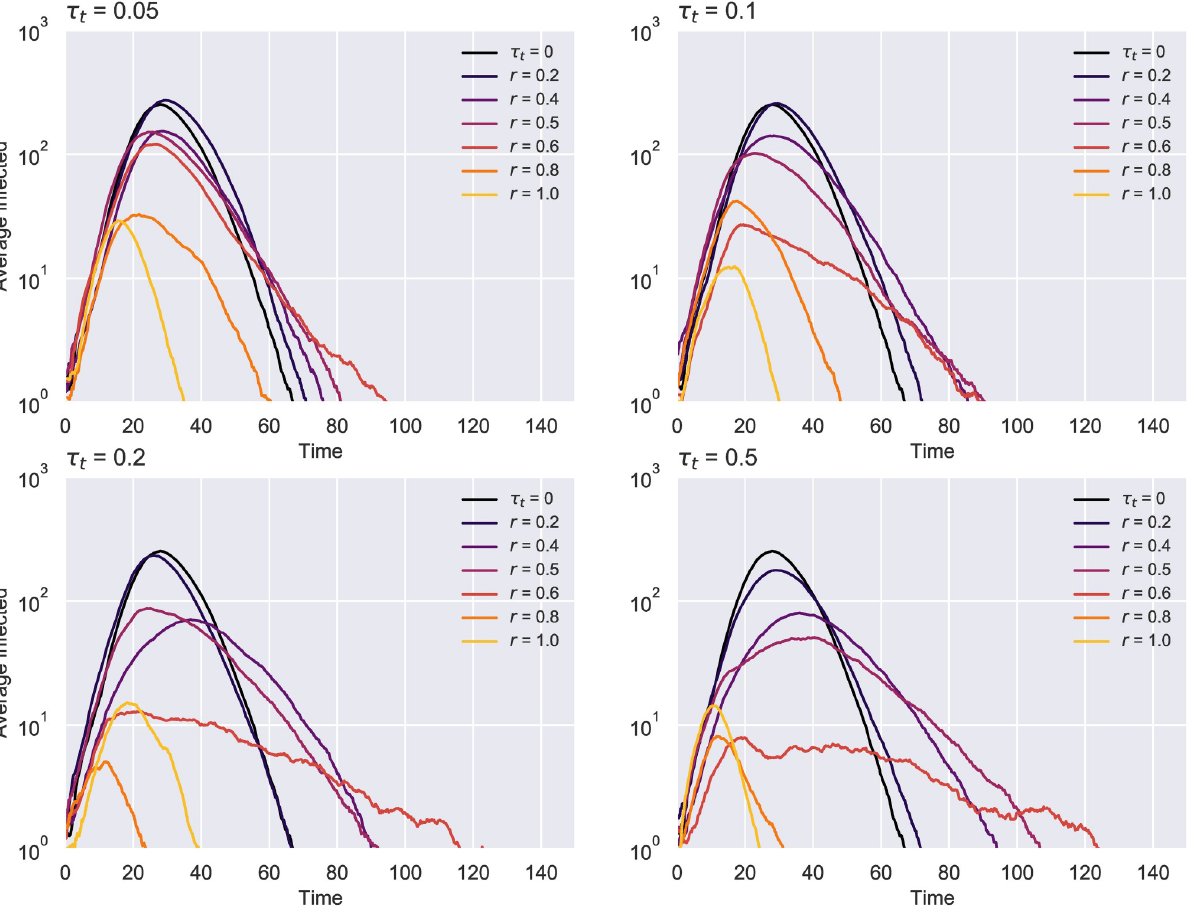
Fig 10. ER network—Epidemic evolution over time for τ r = 0.1 N = 1000 and K = 20. Results averaged over 750 runs. The case with no tracing ( τ t = 0) is colored in black.